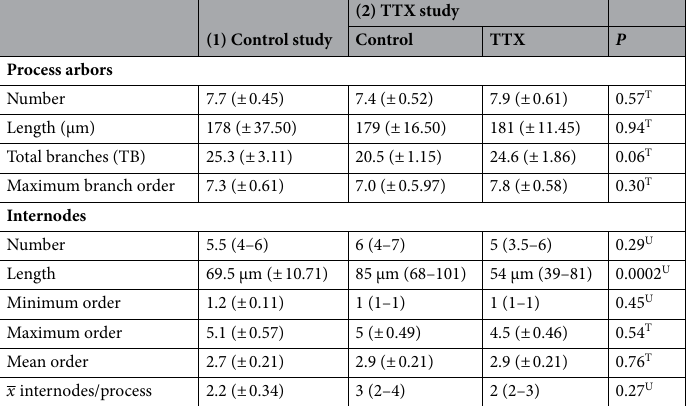
Table 1. Morphology of T OL. Minimum and maximum order refers to order of initiating branch. (1) relates to data shown in Fig. 3, (2) relates to data shown in Fig. 6. Values are Mean ± SEM. P values report comparison of Control and TTX data. T indicates unpaired t test, U indicates Mann–Whitney U